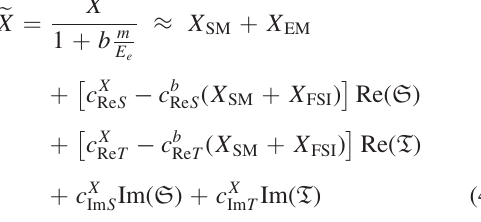
Figure 1. Experimental bounds on the scalar vs. tensor couplings S , T from Eq. (3) (upper panels) and translated to EFT parameters (cid:7) S , (cid:7) T (lower panels). The gray areas represent the information deduced from presently available experiments, while the red lines represent the limits resulting from the correlation coefficients H , L , N , R , S , U and V measured with the anticipated accuracy of 5 × 10 − 4 . Solid, dashed and dotted lines correspond to 1 − , 2– and 3 − σ confidence levels, respectively, in analogy to decreasing intensity of the grey